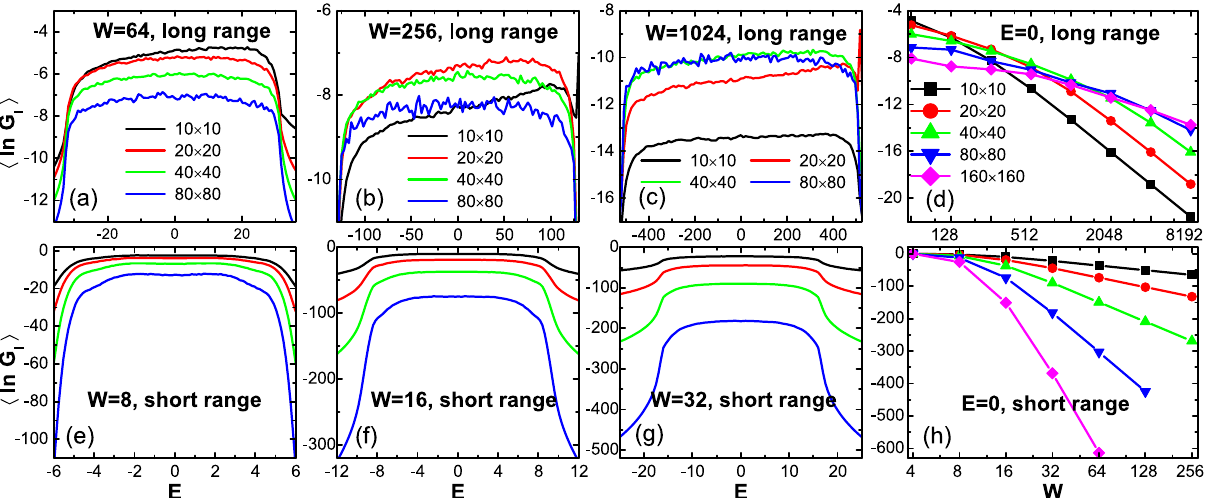
Figure 6. (Color online) Disorder averaged (cid:31) ln G I (cid:30) for the long range model (upper row) and the short range model (lower row). Left three columns: (cid:31) ln G I (cid:30) versus Fermi energy E for different disorder strengths W . Rightmost column: (cid:31) ln G I (cid:30) versus disorder strength W (logarithmic scale) at Fermi energy E = 0 . Curves in different colors correspond to different sample sizes: 10 × 10 (black), 20 × 20 (red), 40 × 40 (green), 80 × 80 (blue), and 160 × 160 (magenta). The number of disorder configurations for averaging is 1000 for 80 × 80 and 160 × 160 , and 5000 for other